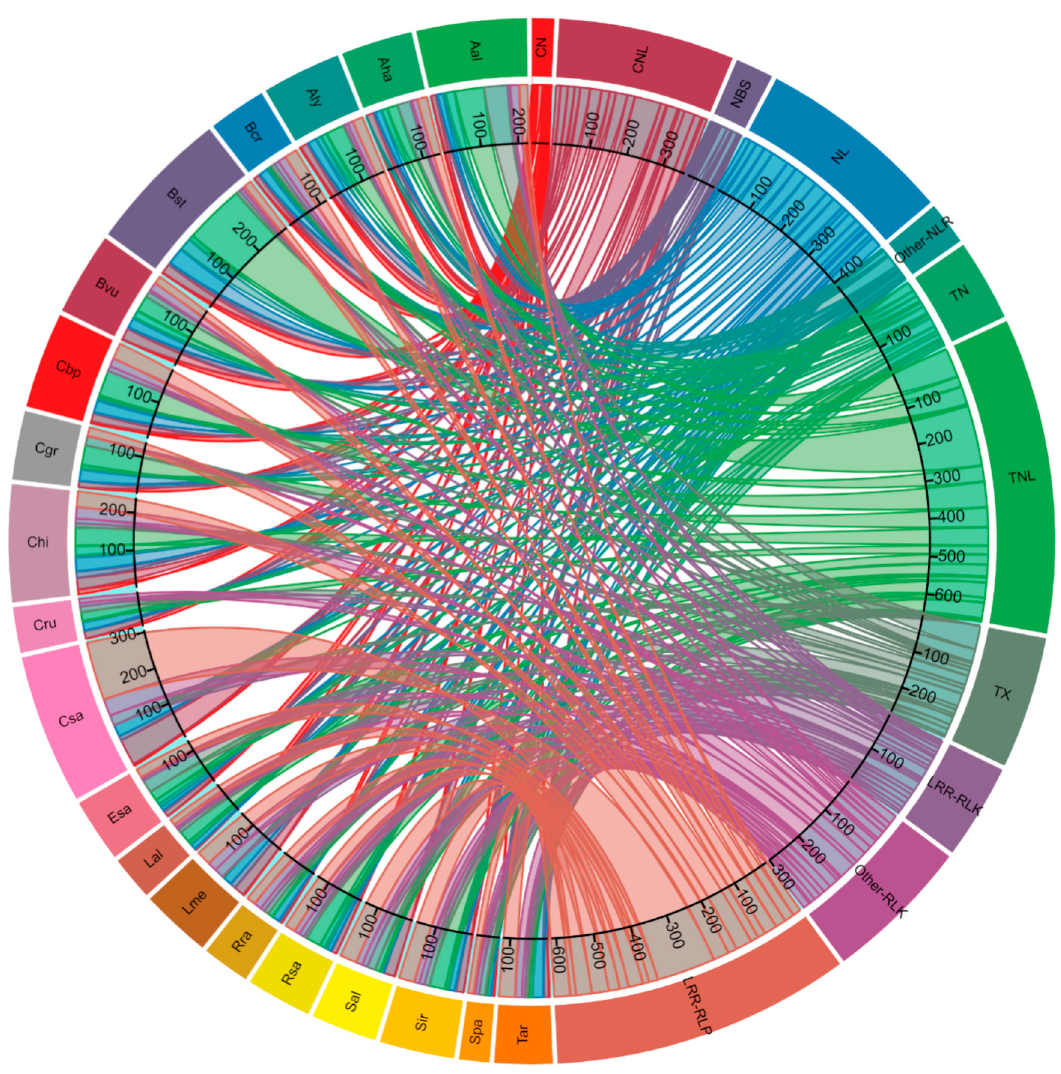
Figure 2. The number and distribution of cloned disease resistance gene homologs containing resistance domains including nucleotide-binding site (NBS), coiled-coil (CC)-NBS or CN, CN-leucine rich repeats (LRR) or CNL, NBS-LRR or NL, Toll/Interleukin-1 receptor (TIR)-NBS-LRR or TNL, TIR-NBS or TN, TIR with unknown domains or TX, NBS-LRR with other domains or Other-NLR, LRR- receptor like kinase (RLK) or LRR-RLK, Lysin motif (LsyM)-RLK or LysM-RLK, RLK with other receptor or Other-RLK, LRR- receptor like protein (RLP) or LRR-RLP and LysM-RLP in Arabidopsis halleri (Aha), Arabidopsis lyrata (Aly), Arabis alpina (Aal), Barbarea vulgaris (Bvu), Boechera stricta (Bst), Brassica cretica (Bcr), Camelina sativa (Csa), Capsella grandiflora (Cgr), Capsella bursa-pastoris (Cbp), Capsella rubella (Cru), Cardamine hirsuta (Chi), Eutrema salsugineum (Esa), Leavenworthia alabamica (Lal), Lepidium meyenii (Lme), Raphanus raphanistrum (Rra), Raphanus sativus (Rsa), Sinapis alba (Sal), Sisymbrium irio (Sir), Schrenkiella parvula (Spa) and Thlaspi arvense (Tar) genomes. The cloned R genes against bacterial leaf spot ( At_ADR1 , At_BAK1 , At_FLS2 , At_NDR1 , At_NRG1a , At_NRG1b , At_PBS1 , At_RLP30 , At_RLP32 , At_RPM1 , At_RPS2 , At_RPS4 , At_RPS5 , At_RRS1 and At_SOBIR1 ) had a total of 752 CDRHs (Figure 3). C. sativa had the highest number of CDRHs, 85, followed by 59 and 58 in C. hirsuta and L. meyenii , respectively (Figure 3). For the gene conferring resistance to another bacterial disease (black rot), At_RLP1 , a total of 36 CDRHs were identified, with the highest numbers found in C. hirsuta and C. bursa-pastoris with 6 and 5, respectively (Figure 3).